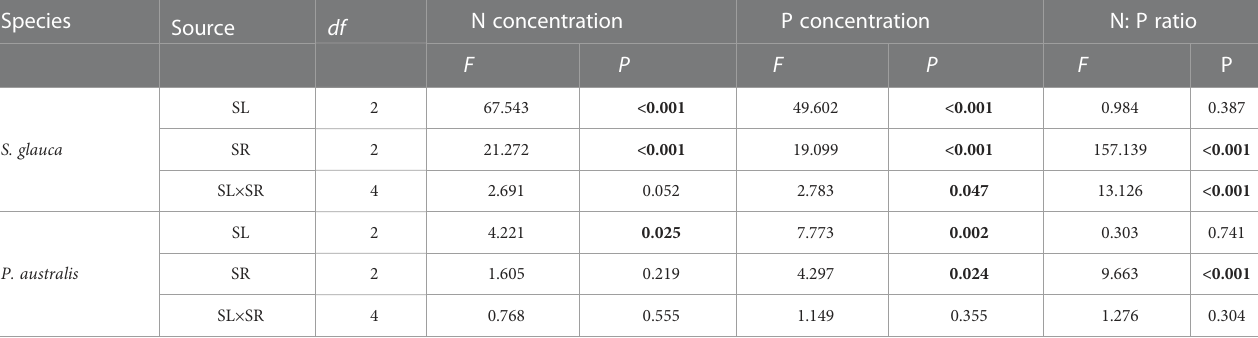
TABLE 2 Two-way ANOVA for N and P concentrations and the N:P ratio of S. glauca and P. australis using the overall supply level (SL) and N:P supply ratio (SR) as the main effects. P-values in bold indicate indicate signi fi cant differences at P < 0.05.